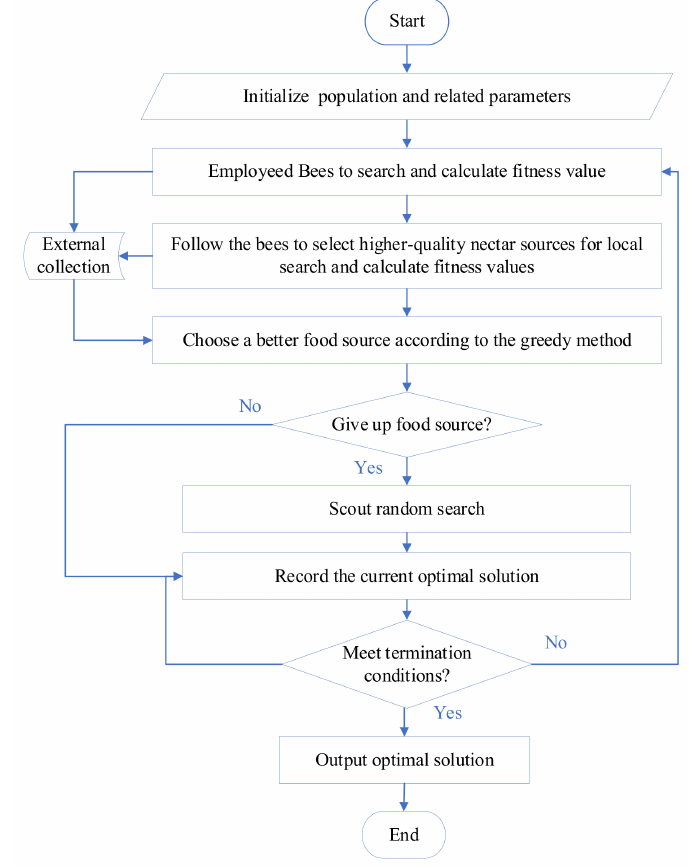
Figure 1. Flow chart of the ABC